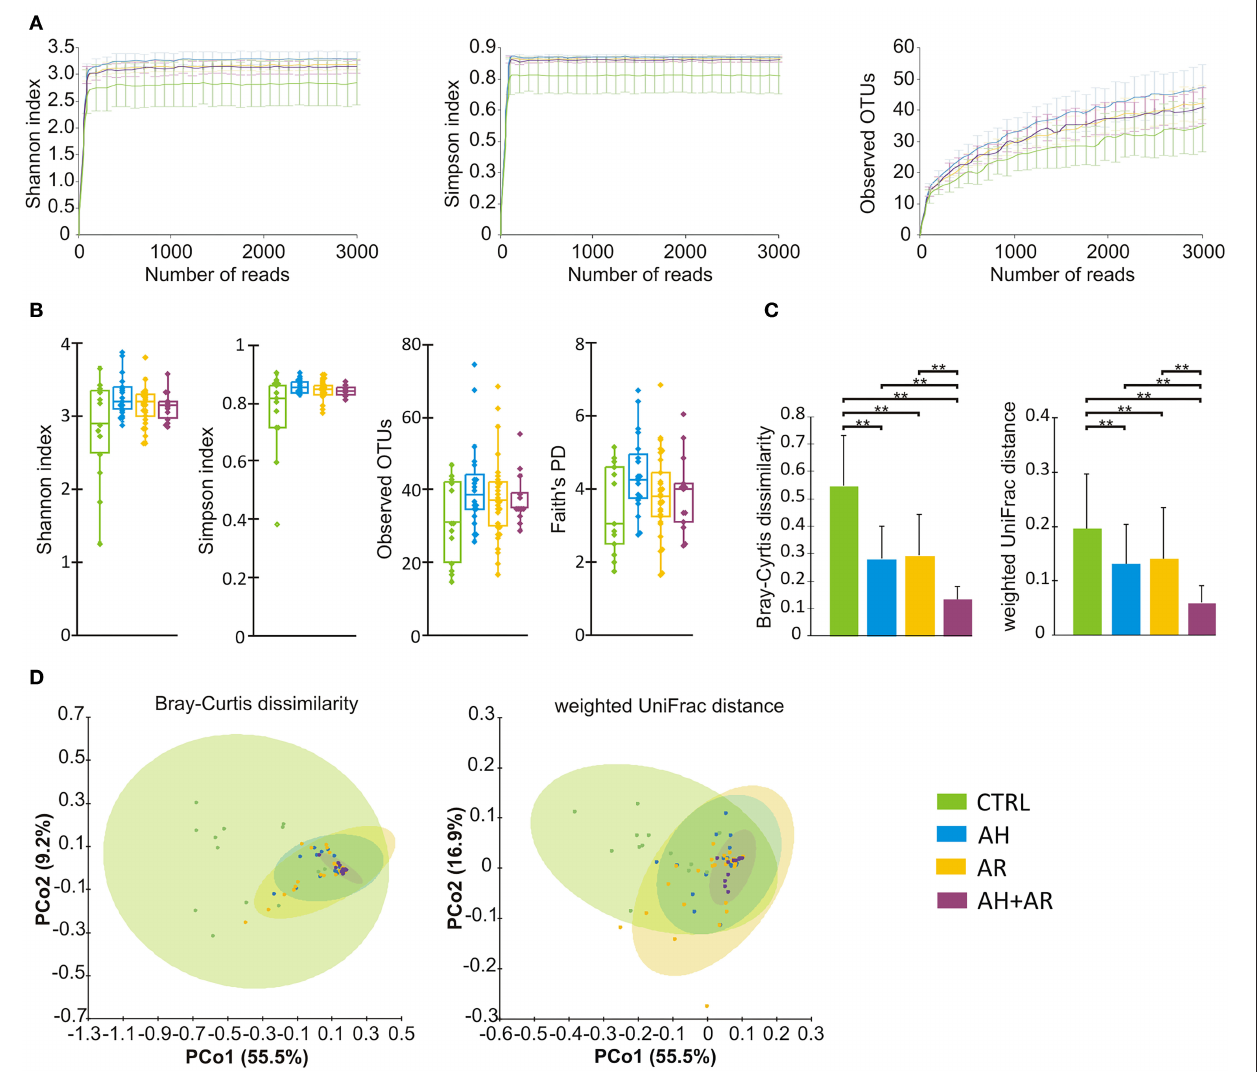
FIGURE 1 | Microbiota diversity analysis. (A) Color coded rarefaction curves. For each group, the average values of α -diversity indexes with 95% confidence intervals were reported at different sequencing depth (B) box plots showing α -diversity estimators, measured for each groups. (C) Barplots relative to the intra-group distribution of the considered β -diversity estimators among groups. Data are expressed as mean ± SD while the presence of statistically significant differences was determined by Kruskal-Wallis rank sum test followed by pairwise Dunn’s post-hoc tests. (D) PCoA plot of bacterial β -diversity based on Bray-Curtis dissimilarity and weighted UniFrac distance according to individual health status. For each group, the 95% confidence interval has been drawn. Numbers between parenthesis represents the percentage of the total variance explained by the principal coordinates. Where needed, the computed p -values were corrected by using the FDR procedure to take into account for multiple comparisons. A p -value ≤ 0.05 was considered statistically significant. ** p <